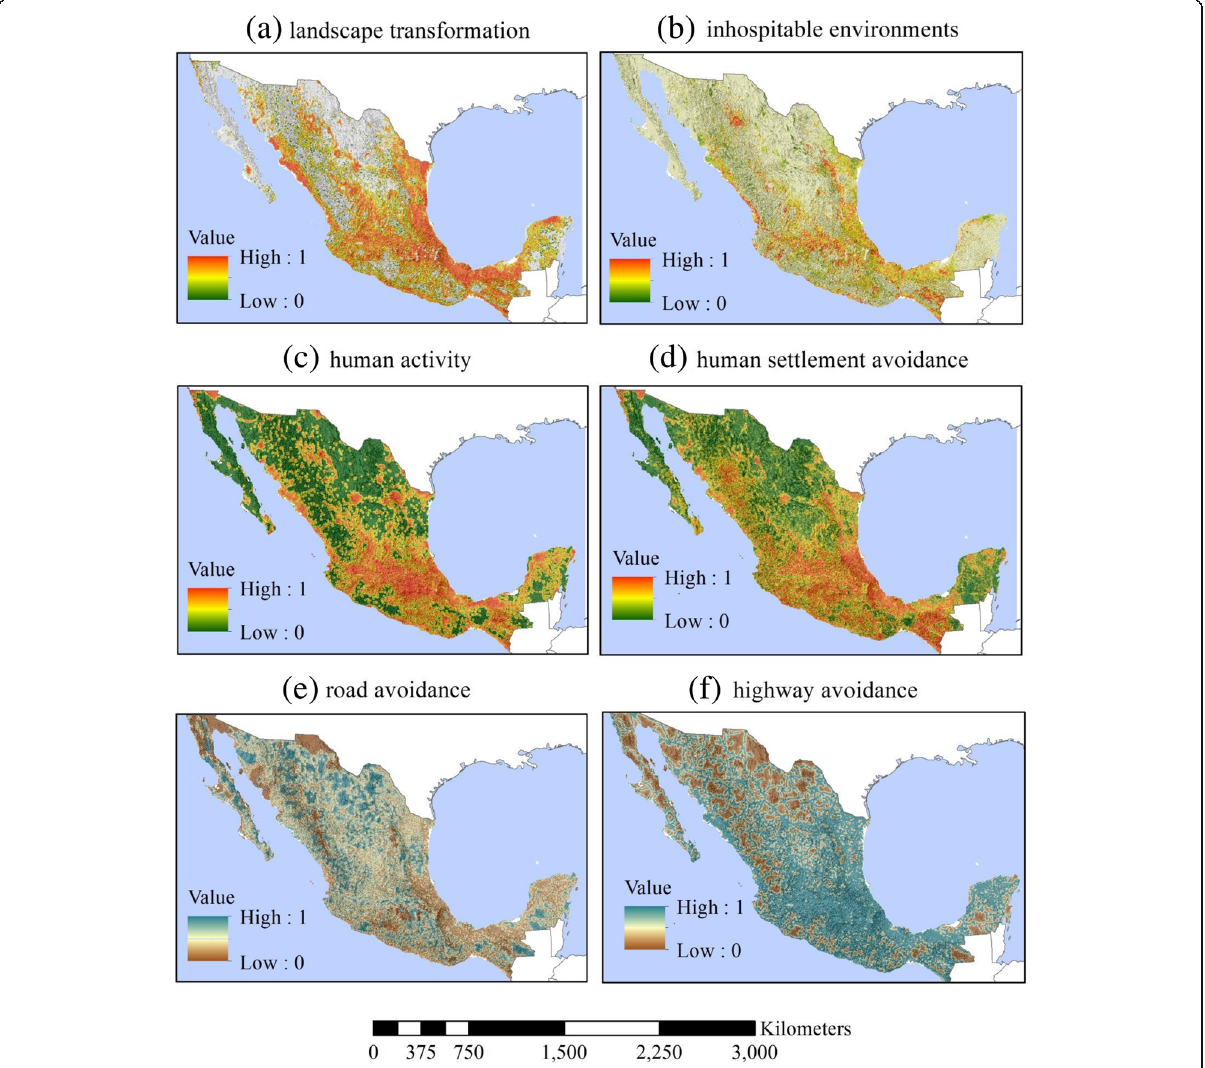
Fig. 3 Spatial indicators of anthropogenic impact. Direct effects are considered as a landscape transformation, b the number of inhospitable environments created by landscape transformation, and c human activity observed with DMSP-OLS night-time imagery. Indirect effects emerged from d human settlements avoidance, e road, and f highway avoidance. All indicators are obtained as focal functions of apex-predators home range (see text for